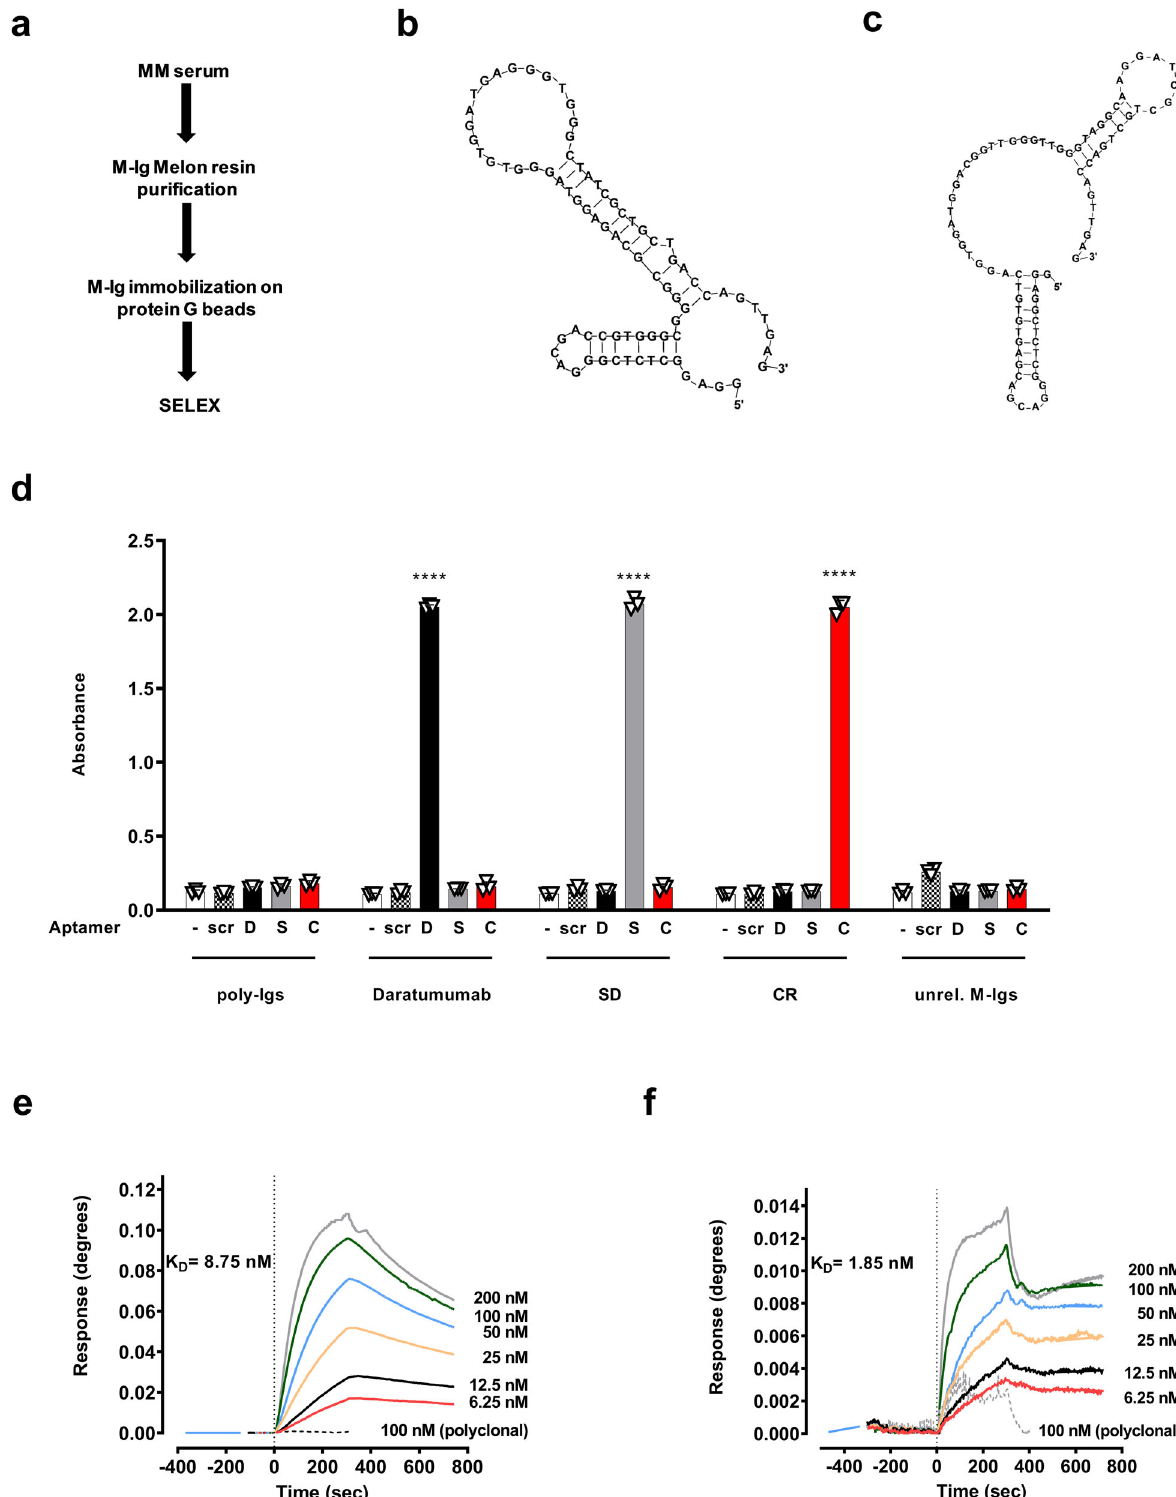
TOPO TA cloning kit and 20 clones were sequenced. Sequences were tested by ELONA and, based on results obtained for binding to daratumumab in buffer and serum, distributed into two families (Supplementary Fig. 1e). Here, we focus on one of them, aptD, that bound to daratumumab in serum (Fig. 1b, left, nucleotide sequence and 2D